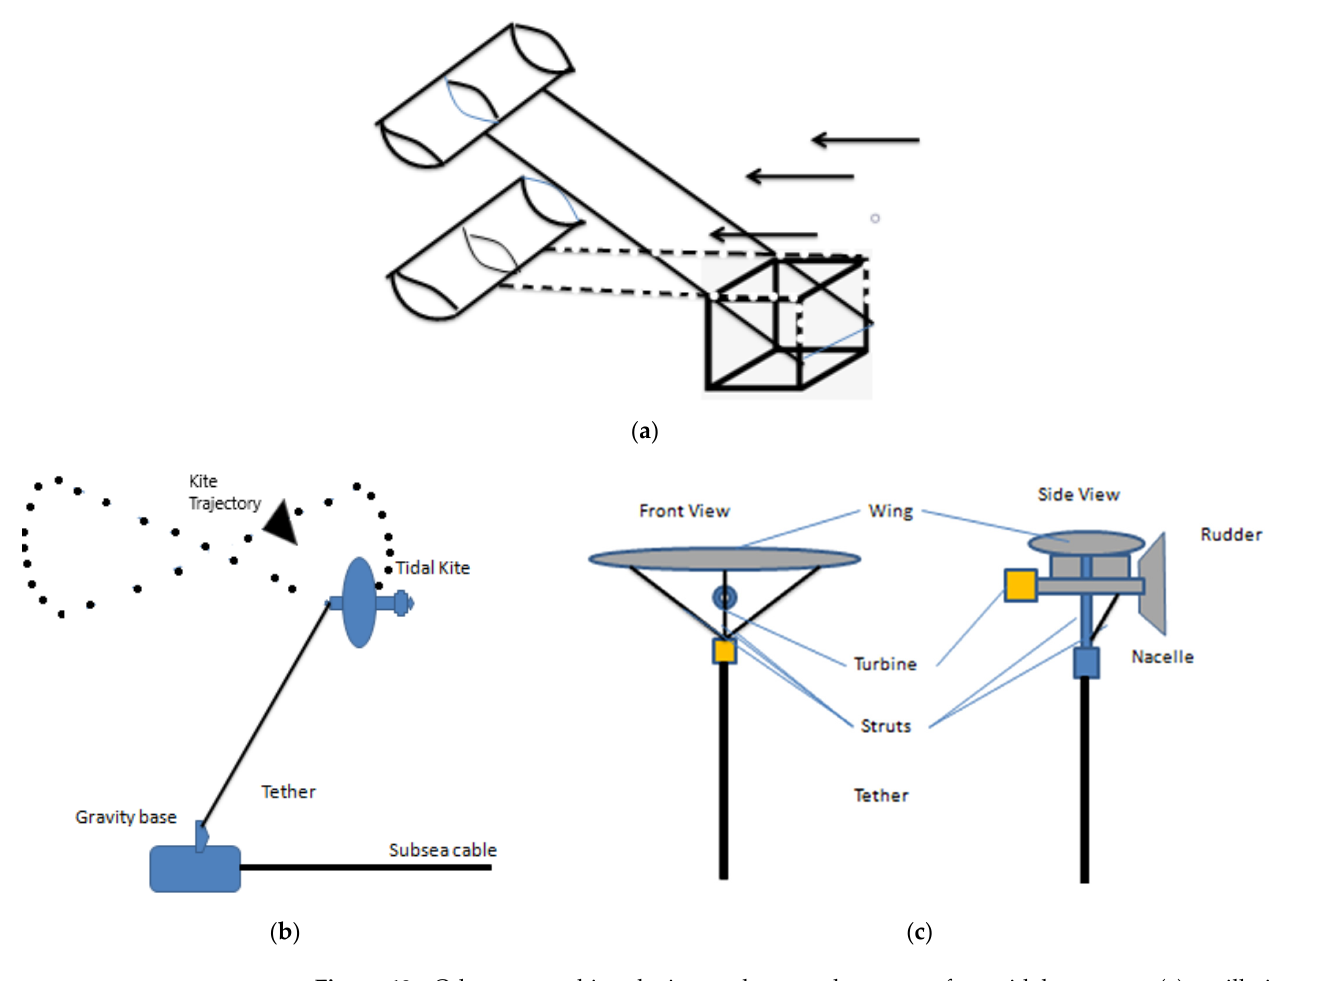
Figure 13. Other non-turbine devices to harvest the energy from tidal currents: ( a ) oscillating hydrofoil and ( b ) general working mechanism of a tidal kite, and ( c ) operating method and schematic of Minesto’s Deep Green tidal kite.